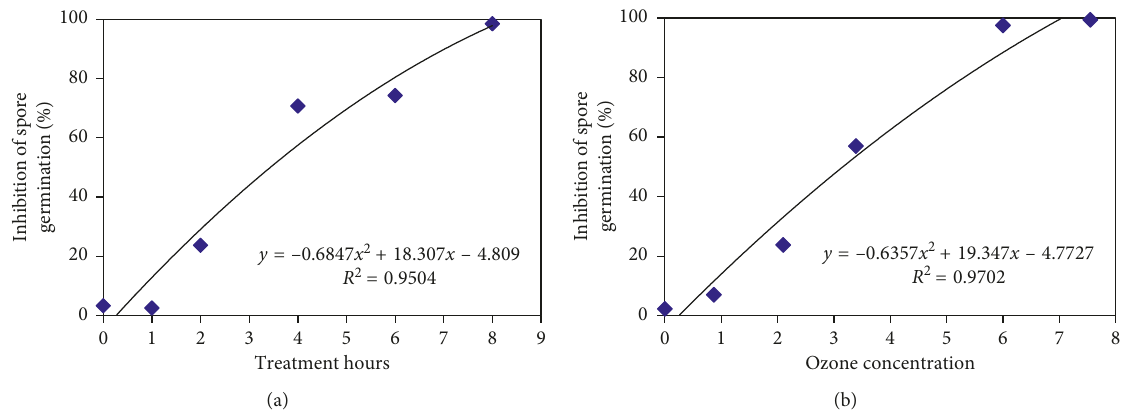
Figure 5: The effect of different plasma treatment time and concentration on the inhibition of germination of Botrytis sp. spore. (a) Plasma treatment of Botrytis sp. spores with different treatment time periods at constant O 3 concentration (CDAP-10%, O 3 : 1.5 ∼ 2.9ppm) and (b) plasma treatment of Botrytis sp. spores with different O 3 concentrations at constant treatment time (2 hours).